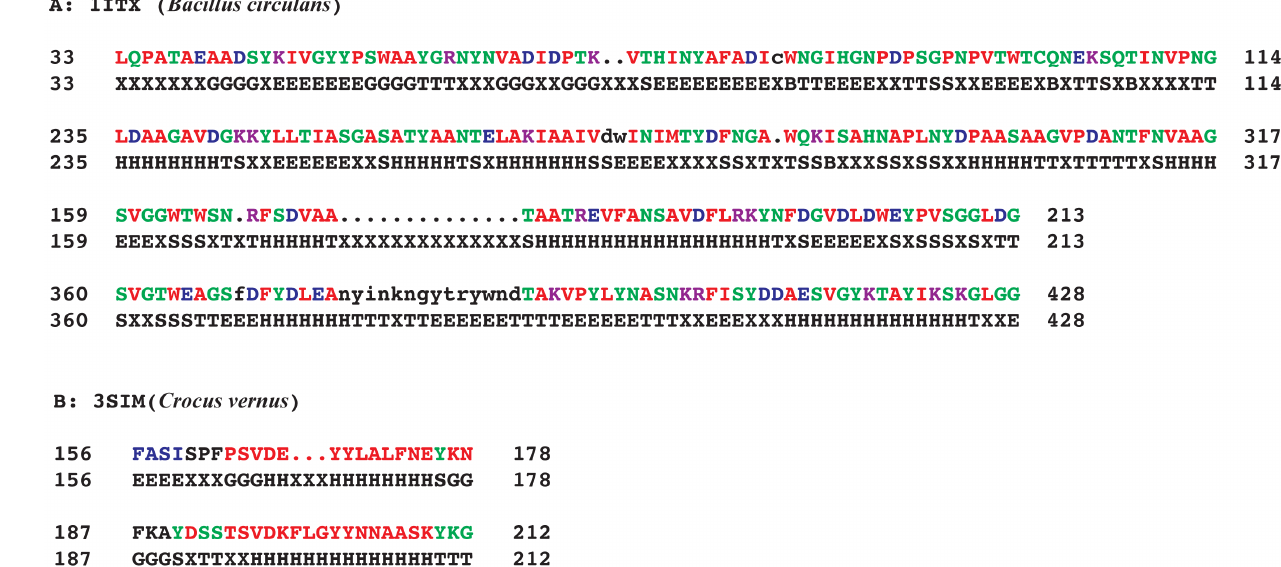
Figure 2. Internal repeats with their corresponding secondary structure. The internal repeats identified using RADAR was used to compare the internal repeats with its secondary structure using secondary structure database of PDB. The structure revealed the secondary structure as follows: T: Turn, E: Beta strand, G: 3/10 helix, B: Beta bridge, S: Bend, H: Alpha-Helix. These five repeats showed similar secondary structures between the internal repeats of corresponding Chitinase sequences. A: 1ITX ( Bacillus circulans ) shows the repeat regions 33-114, 235-317 and 159-213, 360 - 428 and their corresponding DSSP secondary structure assigned from PDB; B: 3SIM ( Crocus vernus ) shows internal repeat regions from 156-178 and 187-212 and its corresponding secondary structure assignments.